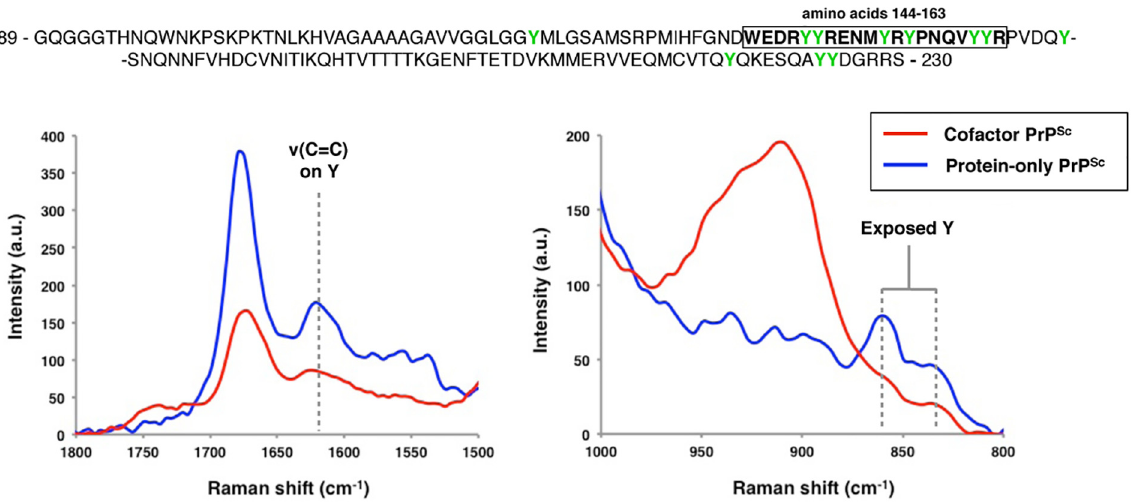
Fig 4. Raman spectroscopy of cofactor and protein-only PrP Sc , focusing on spectral regions assigned to tyrosine side chains. The primary sequence of the region examined by DXMS is shown, with residues 144 – 163 boxed and tyrosine residues highlighted in green. Raman shifts corresponding to the ν (C = C) ring mode (~1620 cm -1 ) and the tyrosine Fermi-doublet (~850 and 830 cm -1 ) are shown.